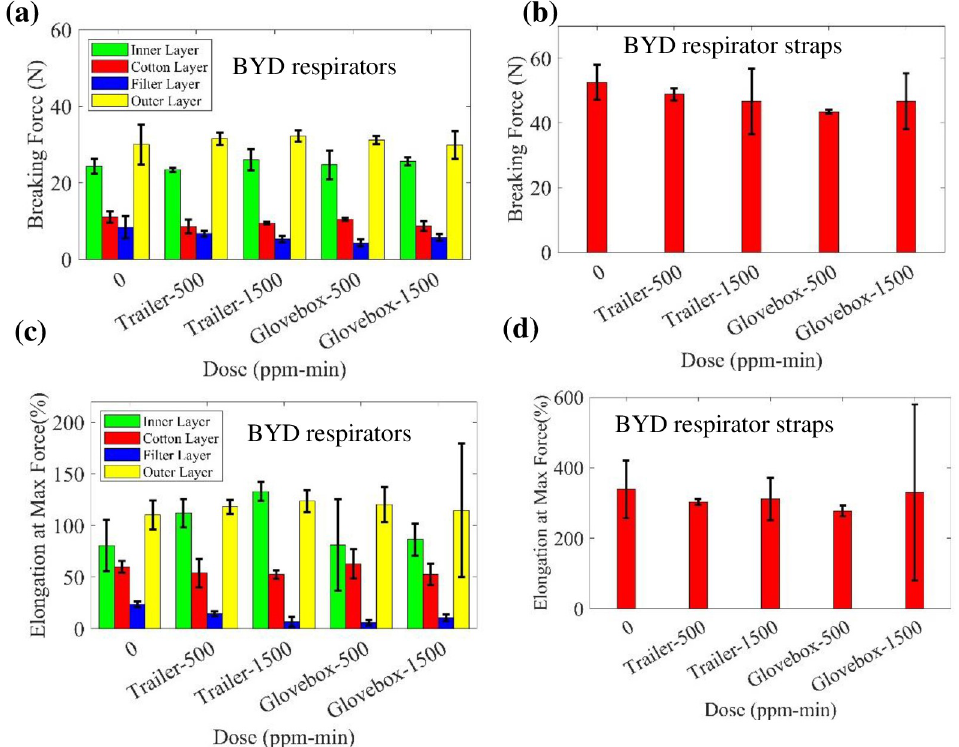
Fig 14. Measured breaking force of treated (a) BYD respirators and (b) straps of BYD respirators. Measured elongation at max force of treated (c) BYD respirators and (d) straps of BYD respirators.